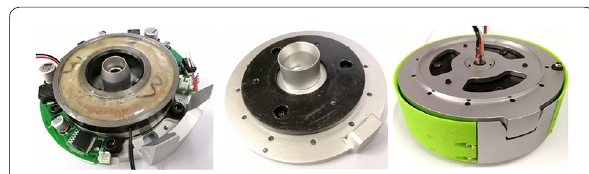
Figure 18 Prototype of the electromagnetic RCM